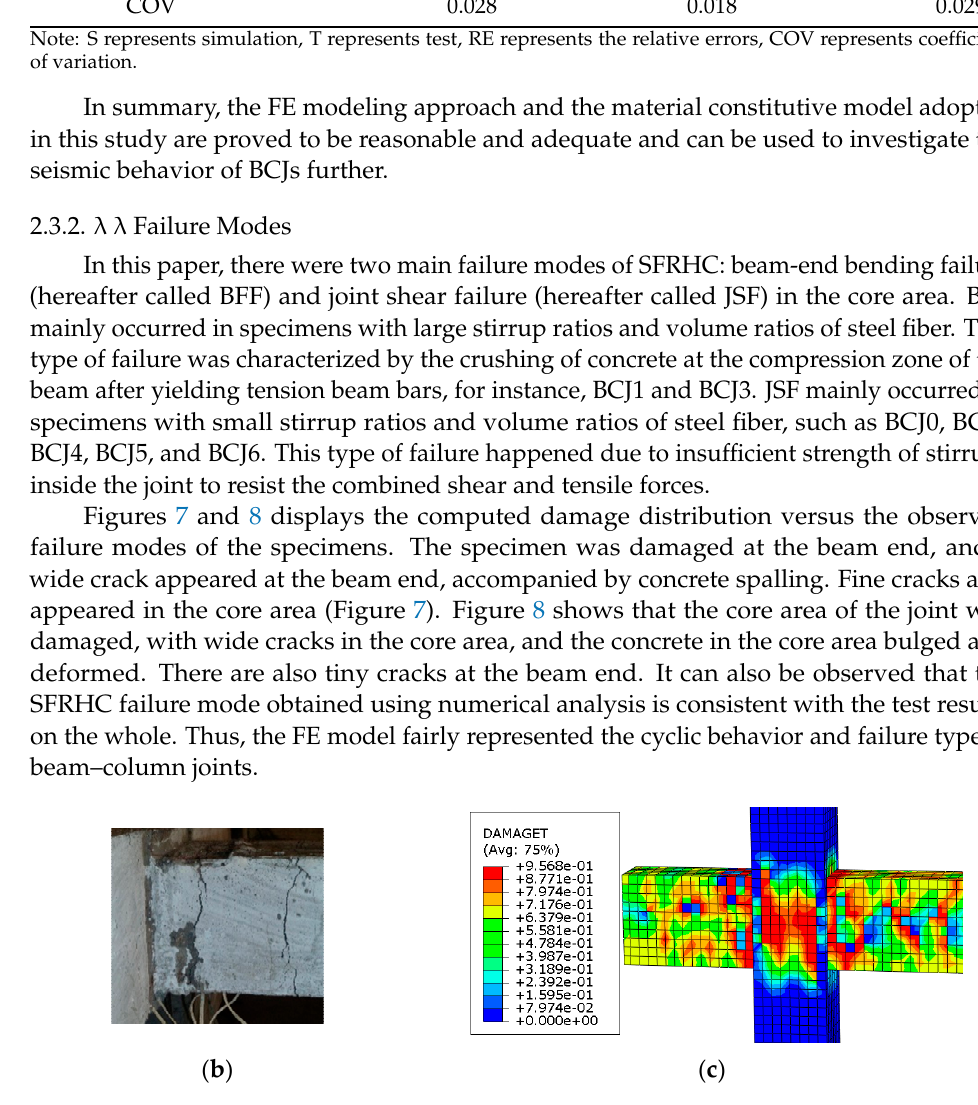
Figure 8. Failure model of BCJ5 specimen: ( a ) in the beam of test; ( b ) in the core joint of test; ( c ) in the FE analysis. 3. Seismic Behavior Analysis and Discussion Based on the validated FE modeling approach, the FE models are developed to further investigate the seismic performance of beam – column joints in terms of the